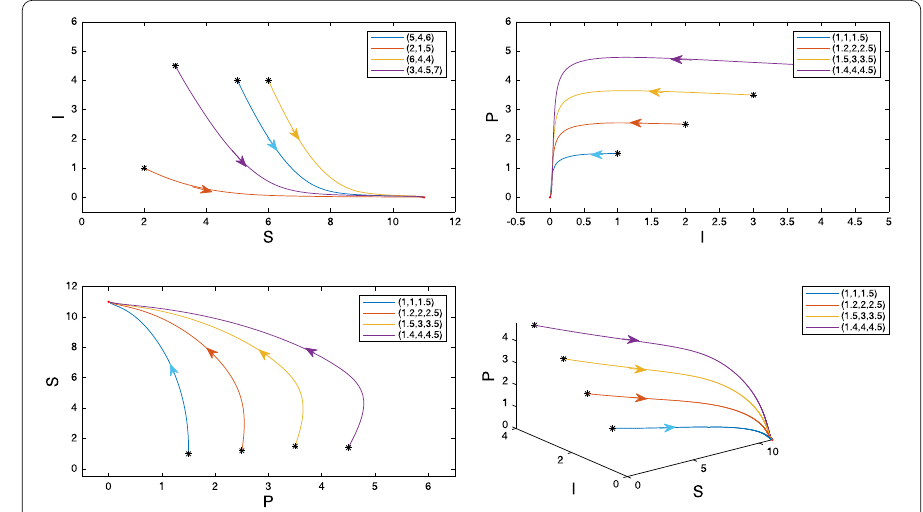
Figure 7 Global asymptotic stability of the axial equilibrium point E 1 with different initial values when β = 0.02 and q = 0.9